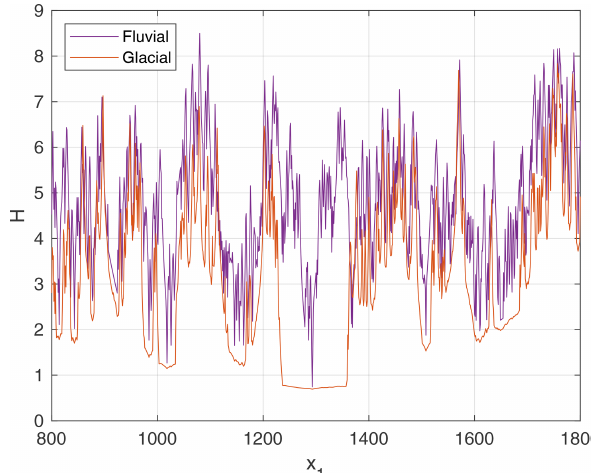
Figure 4. Glacial equilibrium topography under uniform uplift with the entire precipitation converted into ice. The red line refers to the profile shown in Fig. 4.